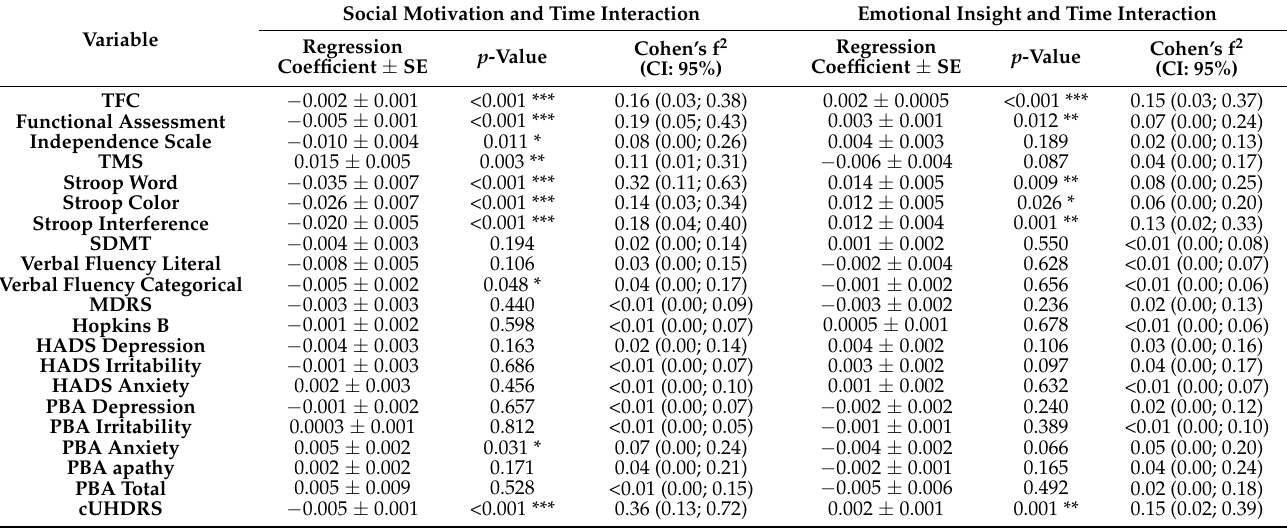
Table 4. Associations between subdomain scores at baseline and disease progression.